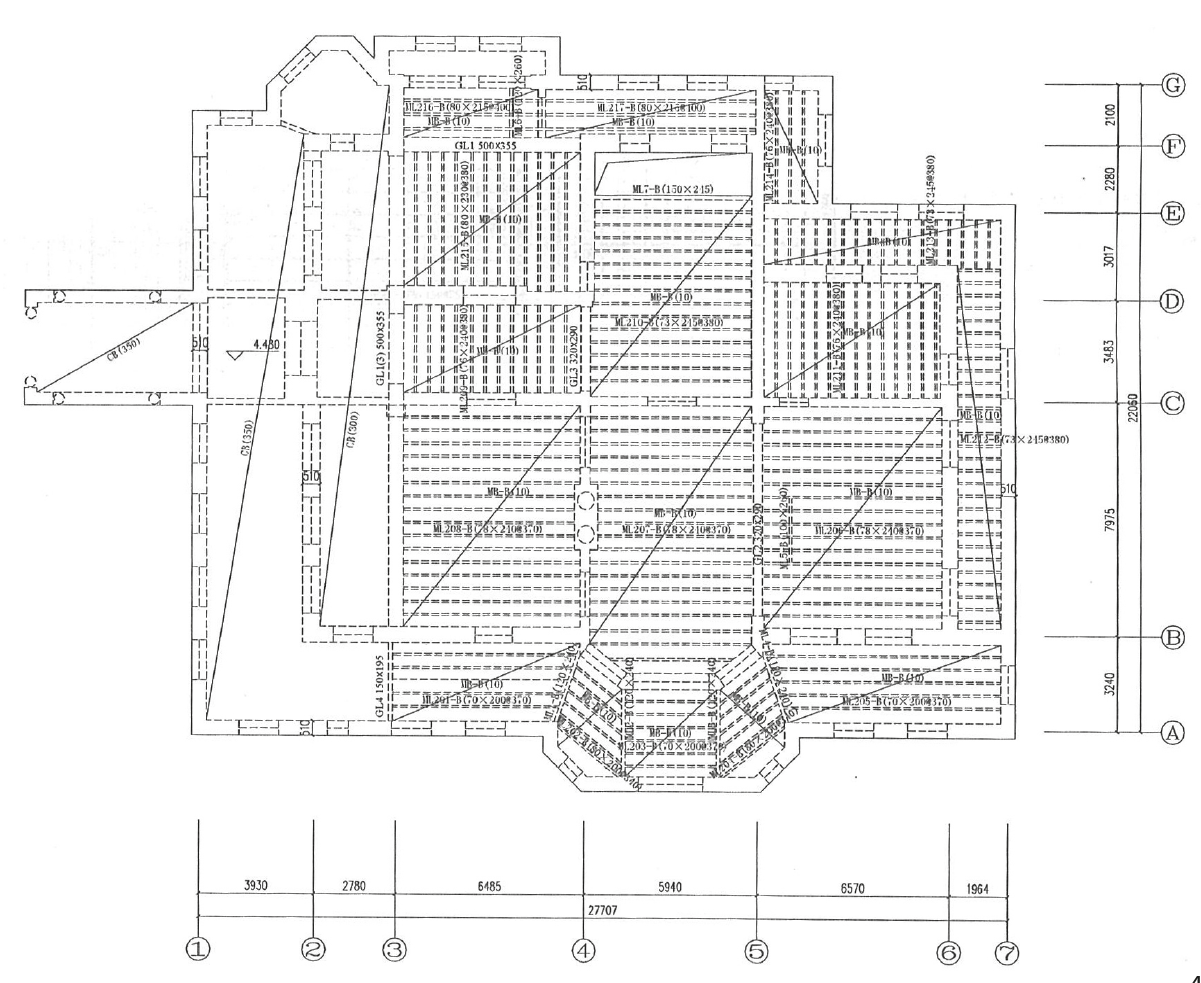
Figure 4 Second floor structural plan of the former British Consulate House (Source: the author).